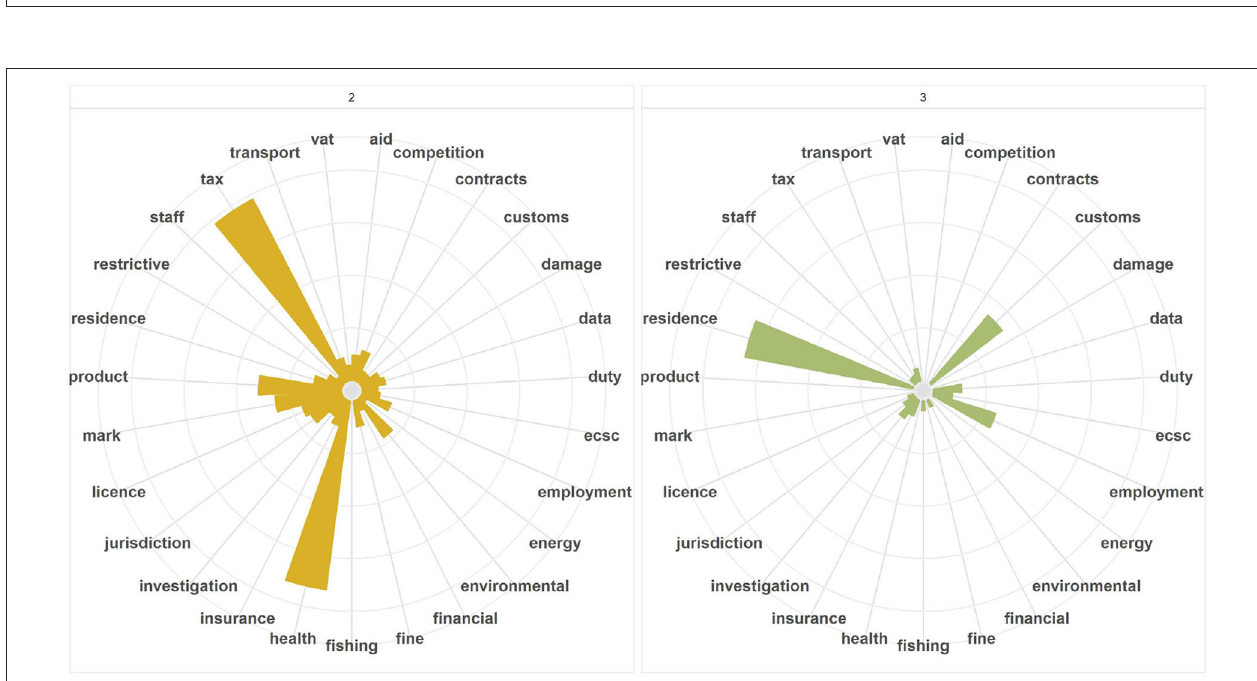
FIGURE 7 | Average topic proportion in network community two (EEA Agreement) and three (Ankara Agreement) identified via fast-greedy algorithm [24]. Values closer to the origin of the circle indicate lower topic proportion. Topics are labeled using the topmost characteristic word.